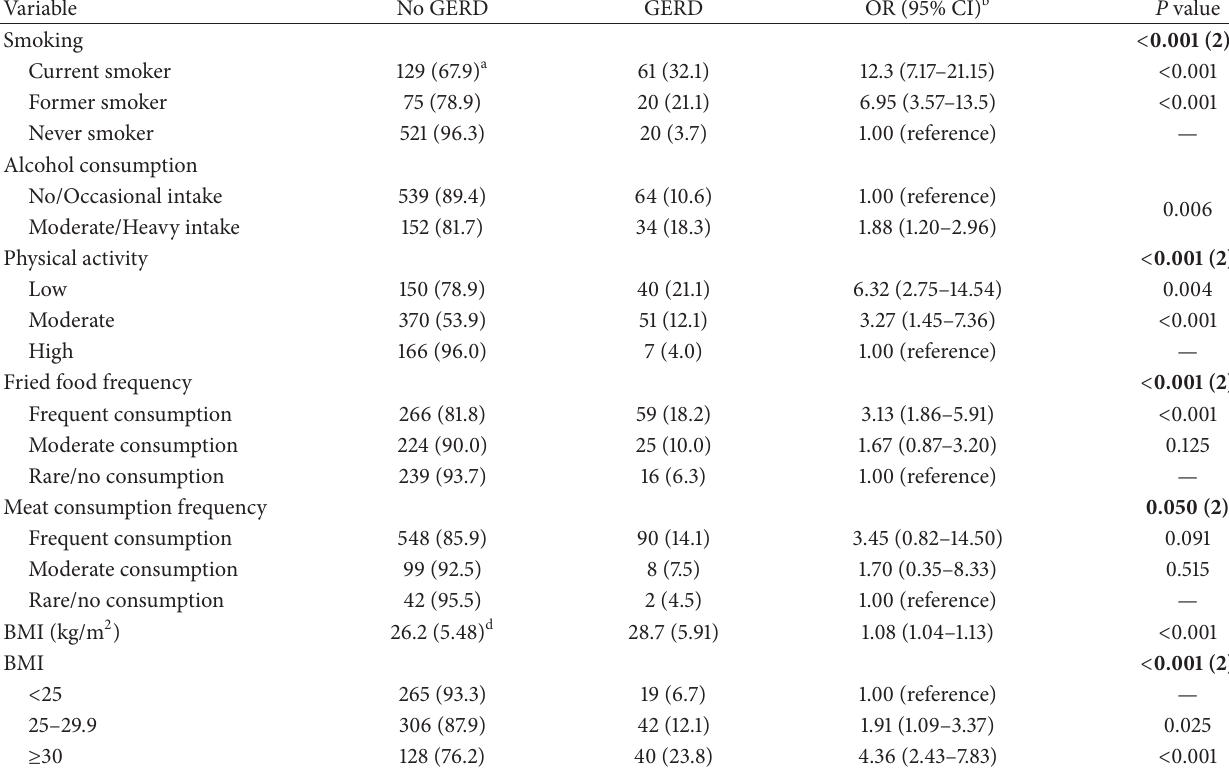
a Numbers and row percentages (in parentheses). Discrepancies in the totals are due to missing covariate values. b Unadjusted (crude) odds ratios (ORs: GERD versus no GERD), 95 % confidence intervals (95 % CIs), and P values from binary logistic regression. c Overall P value and degrees of freedom (in